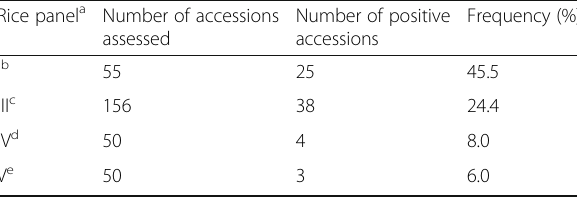
Table 2 Frequency of Pi2 orthologues in different rice panels diagnosed by using the primer pair